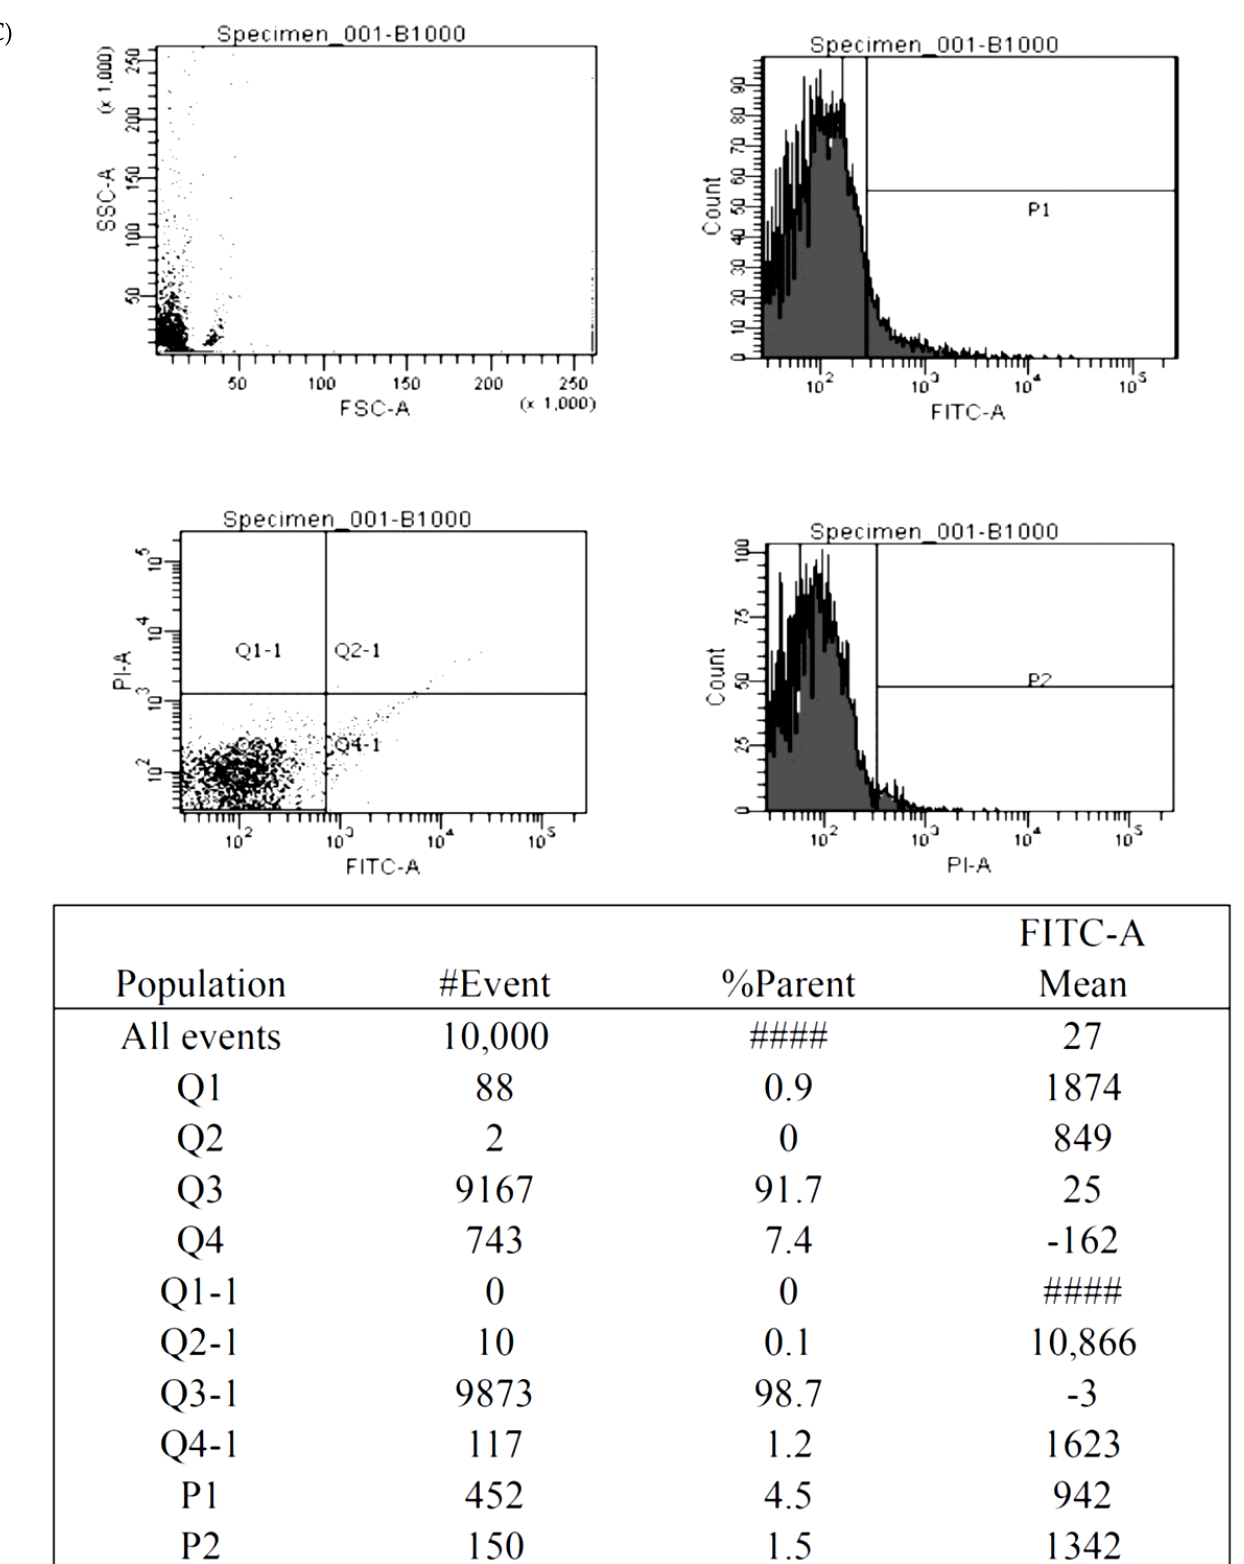
Figure 5. The illustration of the Annexin V-FITC apoptosis assay for the BMSCs treated by control ( A ), 1000 nM Y1R agonist (Leu 31, Pro 34) ( B ) and 1000 nM Y1R antagonist BIBO3304 ( C ). The P1 value quantified cellular necrosis, and the P2 value quantified cellular apoptosis.